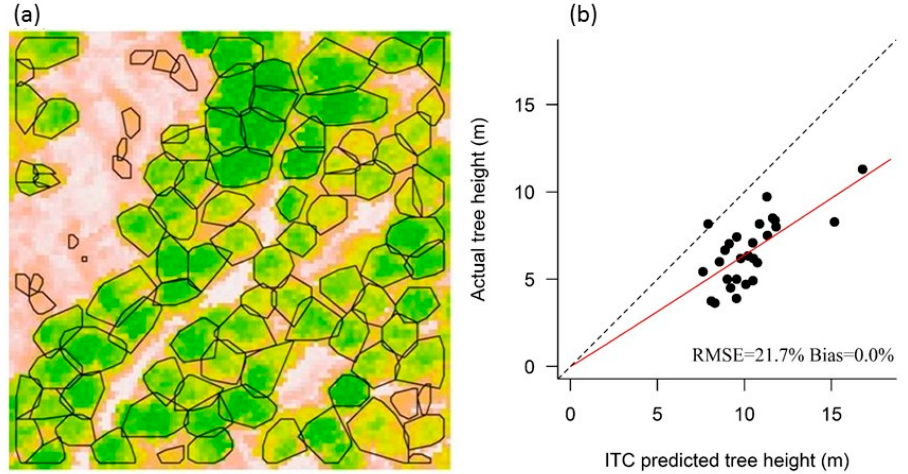
Figure 7. ( a ) Detection of individual tree crowns in a 1-ha plot LiDAR imagery using itcSegment (Dalponte and Coomes, 2016) for oil palm plantations; ( b ) The relationship between tree stem height obtained from field data and tree height obtained from the individual tree crown segmentation (H ITC ). The regression line fitted to all 27 plots is shown as a red line and the 1:1 line as a black dashed line. A comparison of the number of delineated trees with the tree density obtained from the Pléiades optical imagery was used to estimate the accuracy of the ITC delineation for all the 1-ha plots (Figure 8a). ACD of individual oil palm trees was summed to estimate plot ACD at the 1-ha plot level (Figure 8b). The ITC approach gave a percentage RMSE of 25.9% and was biased ( − 11.6%), showing a slight trend from over-estimation of lower carbon density values and under-estimation of higher carbon density values.